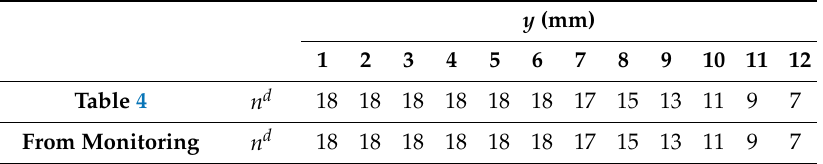
Table 20. Comparison between n d from di ff erent sources in